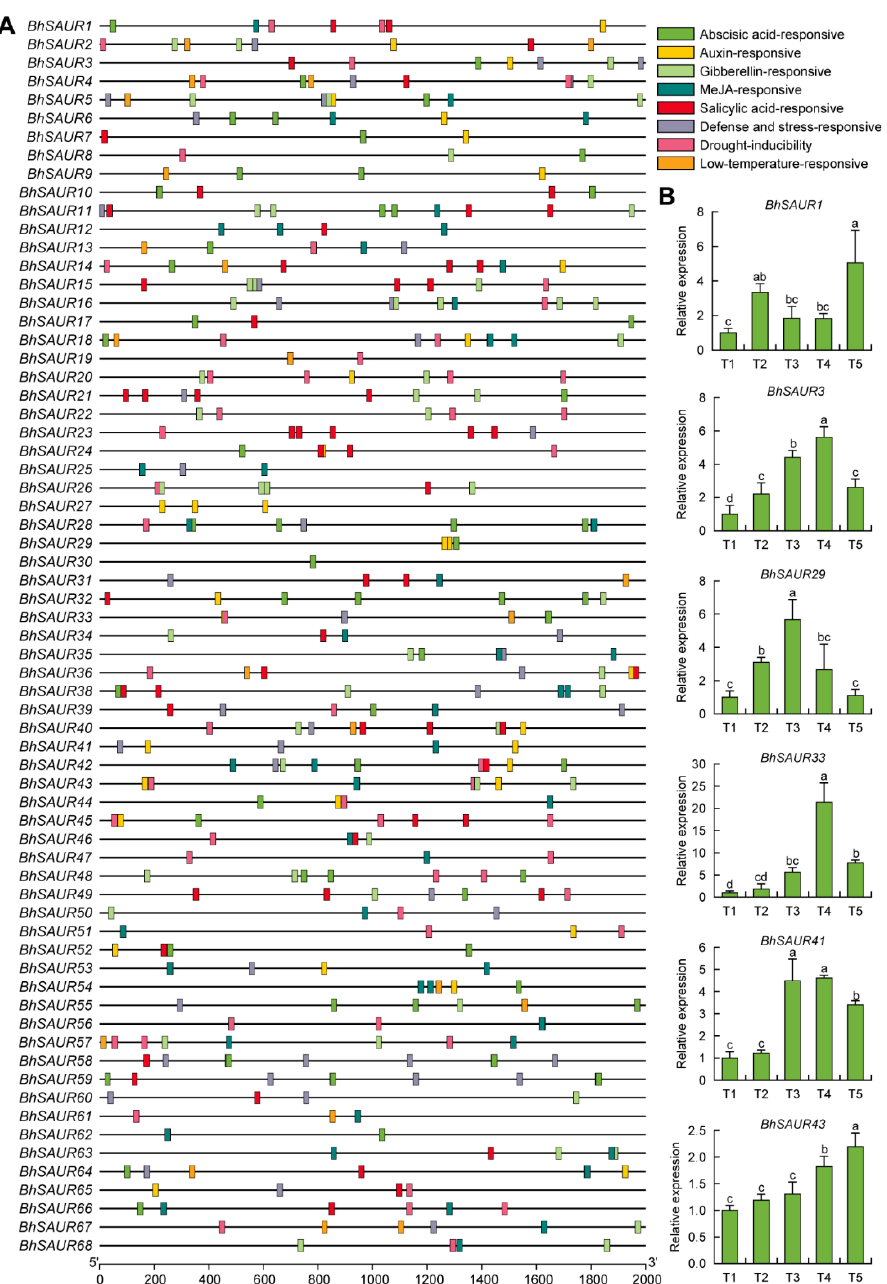
Figure 5. Cis -acting element analysis of the BhSAUR gene promoters. ( A ) Cis -acting elements in the promoters of the BhSAUR genes; ( B ) expression analysis of the BhSAUR genes under IAA treatment. T1, T2, T3, T4, and T5 represent 0, 10, 30, 60, and 120 min after IAA treatment, respectively. Values are means ± SDs ( n = 3). Different lowercase letters indicate significant differences determined by one- way ANOVA with Duncan’s test ( p < 0.05).